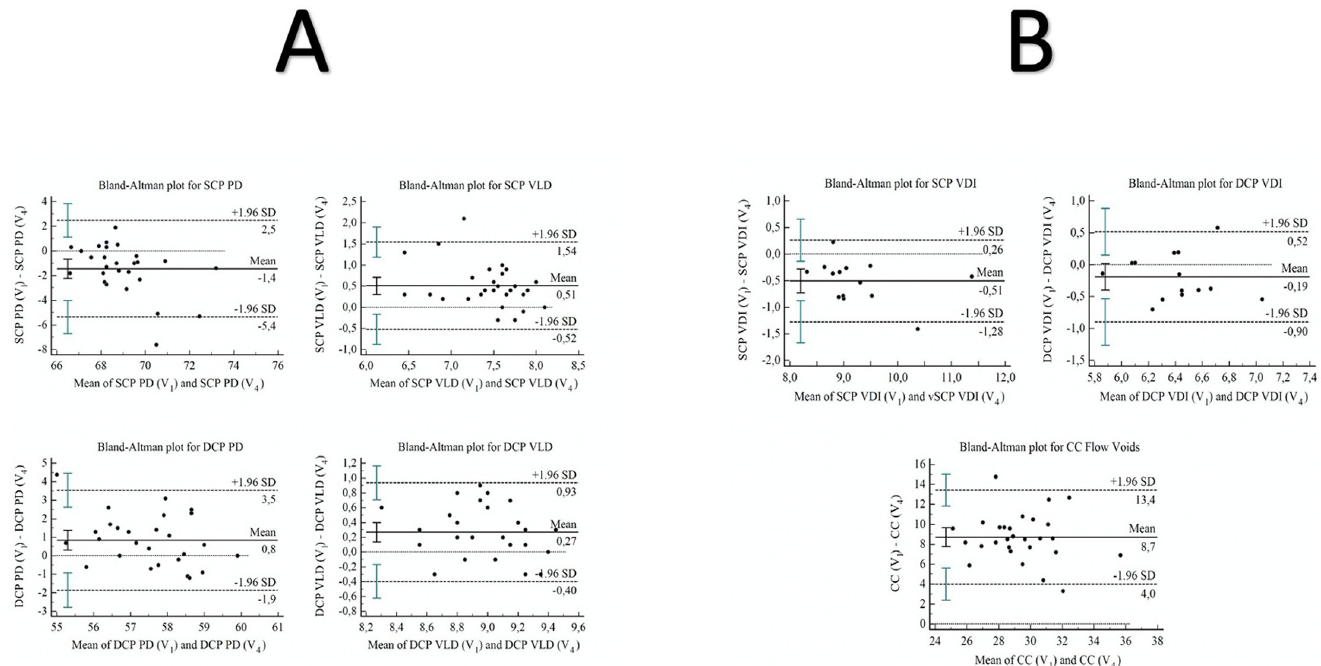
Fig 4. Bland-Altman plots to assess concordance between methods reporting mean between methods for SCP PD, SCP VLD, DCP PD, and DCP VLD variables (A) and SCP VDI, DCP VDI, and CC flow deficits variables (B) reporting on x-axis and differences between methods on the y-axis.